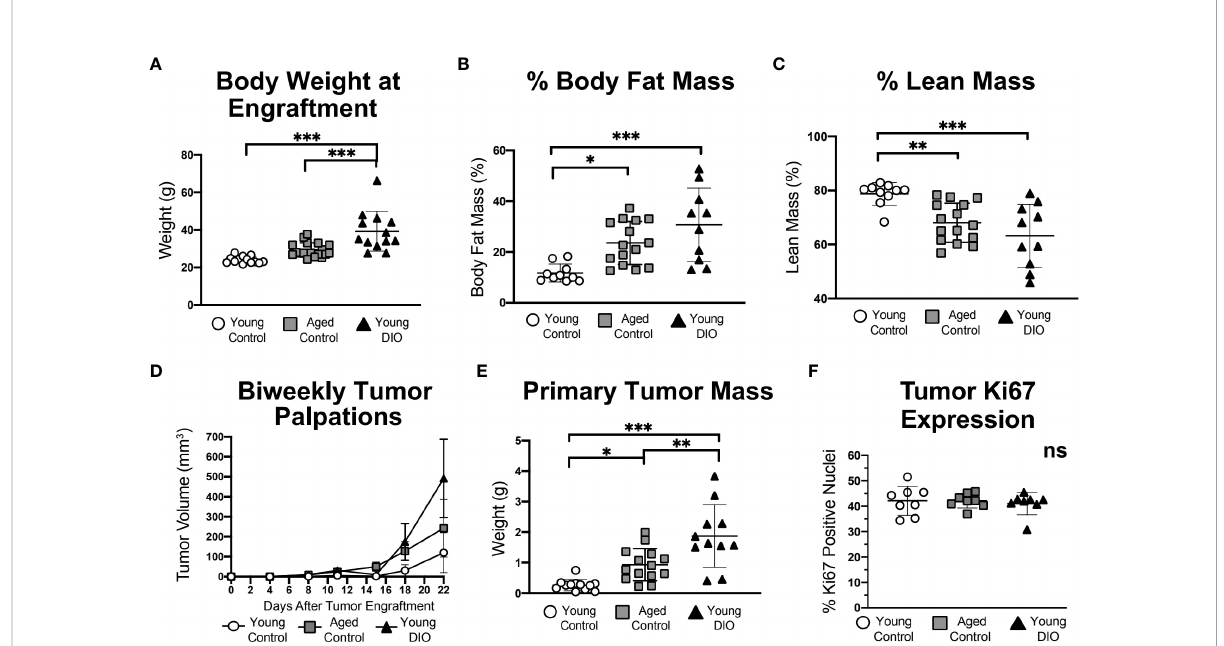
FIGURE 1 Advanced age and DIO increase mammary tumor growth in a metM-Wnt lung cell transplant model of TNBC. (A) Body weight, (B) percent body fat mass and (C) percent lean mass measured prior to tumor engraftment. (D) In vivo tumor volume. (E) Ex vivo primary tumor mass. (F) Percentage of cells stainedpositive for Ki67 via immunohistochemistry,analyzed using QuPath. Data presented as mean ± SD.Differences across all groupsanalyzed usingone-way ANOVA andTukey post hoc test.Asterisksindicate differences in signi fi cance: *p< 0.05, **p < 0.01, ***p< 0.001. ns, non-signi fi